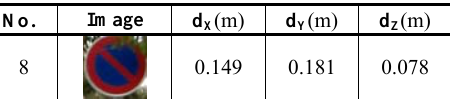
Table 1. Examples of recognized traffic